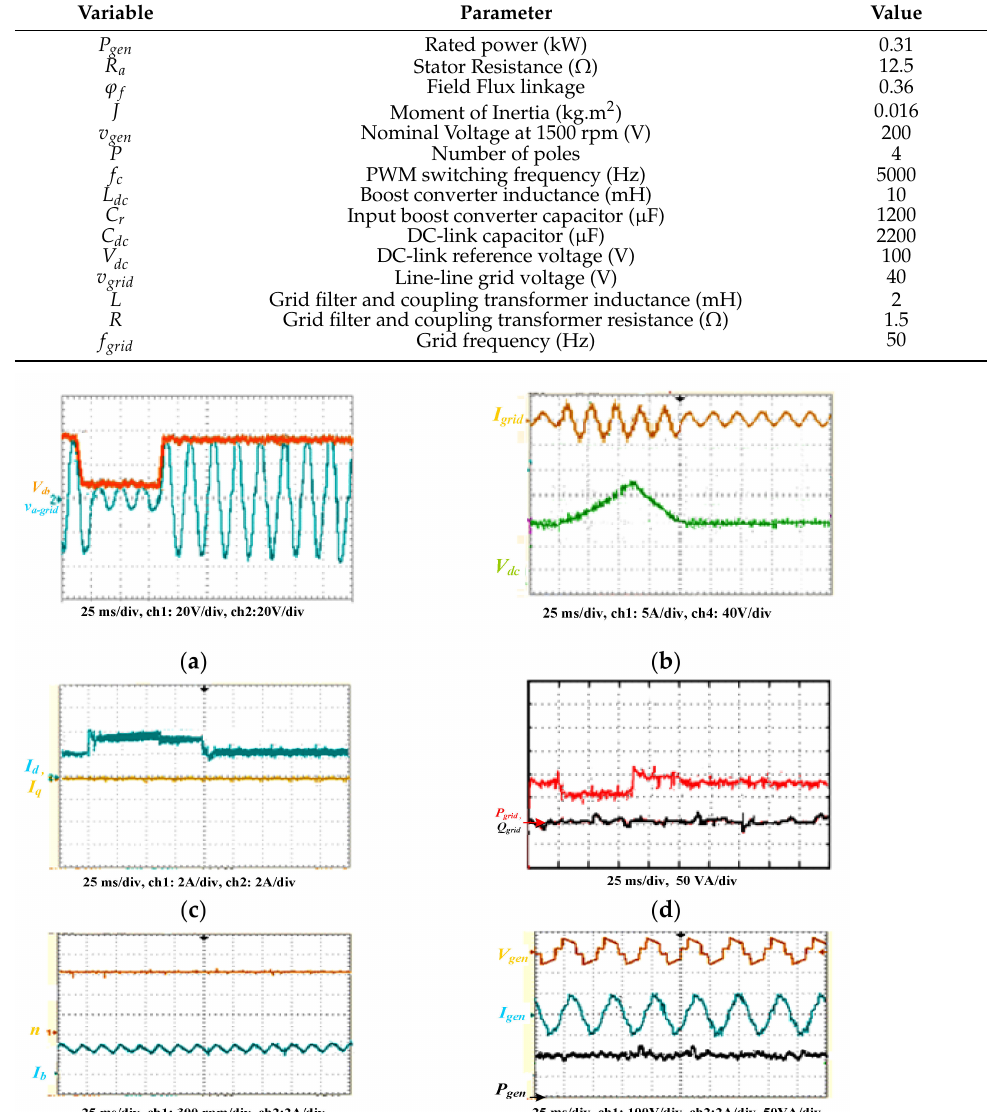
Table 4. Experimental set-up parameters.